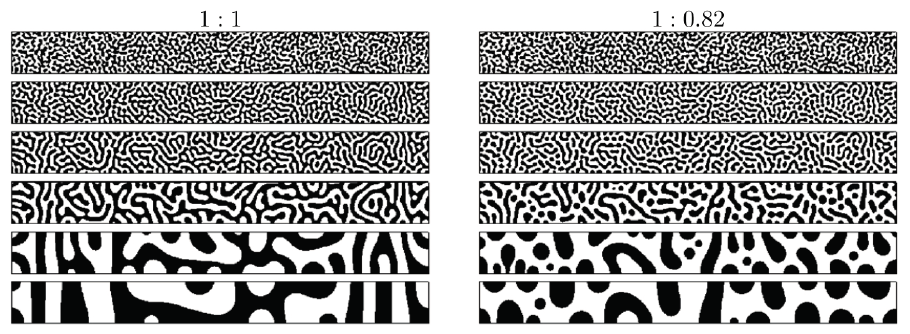
Figure 16. Representative two-phase morphology evolution obtained via numerical simulation of thermal annealing for two blend ratios (1:1 and 1:0.82) from early stages (first row) until the final time (consecutive rows). Efficiencies as a function of annealing time t (dimensionless) for two different blend ratios. Plots show estimates of efficiencies for blend ratios 1:1 and 1:0.82. Cited from [122]. Copyright 2012, Elsevier.